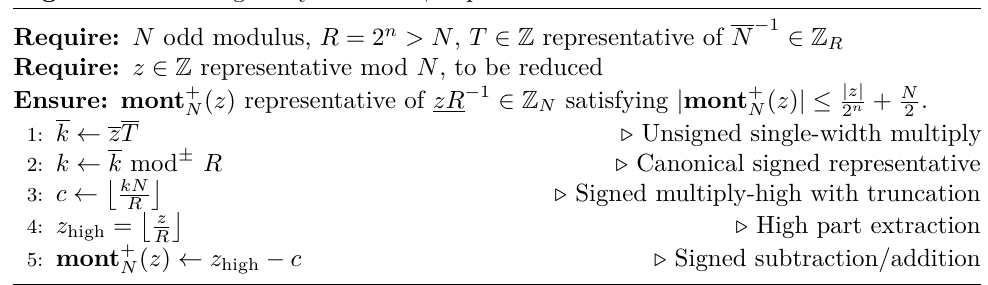
Algorithm 4 Montgomery reduction,